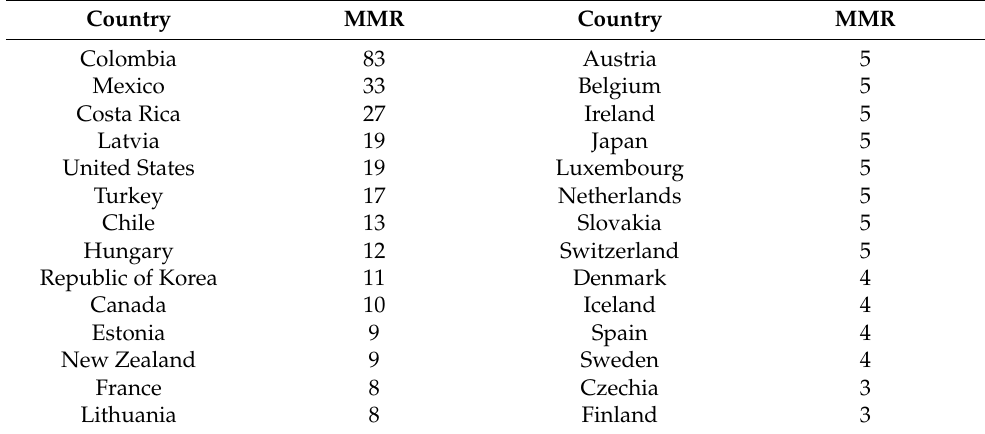
Table 3. Maternal Mortality Rates in the Organisation for Economic Cooperation and Development countries (OECD) 2017.